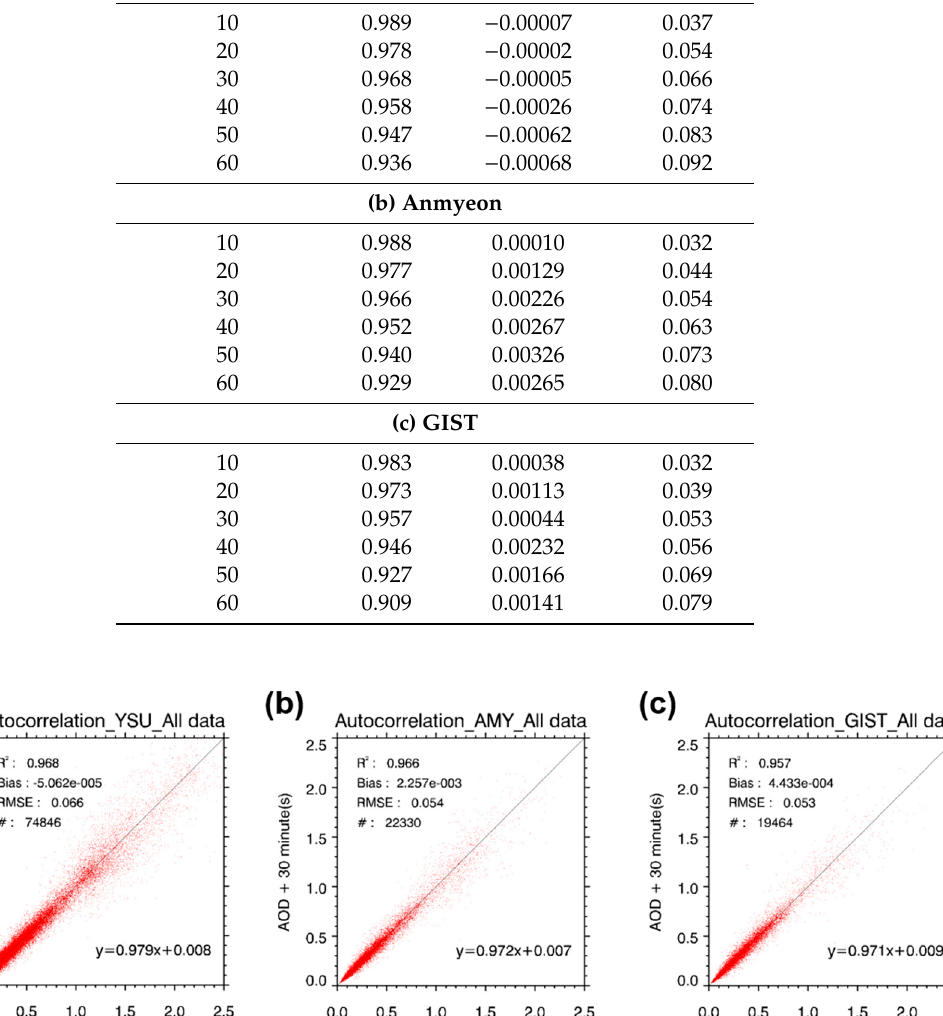
Table 2. Statistical results for temporal variability of AOD with time lag change at ( a ) Yonsei University, ( b ) Anmyeon, and ( c ) GIST.